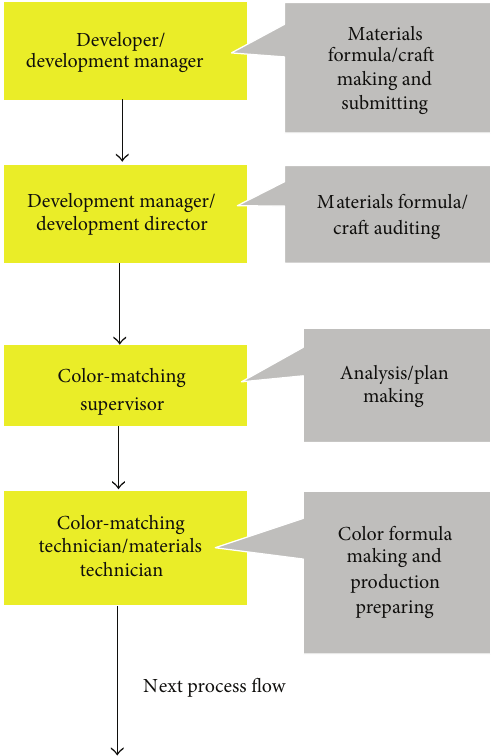
Figure 2: Flow chart of applying workflow evaluation.